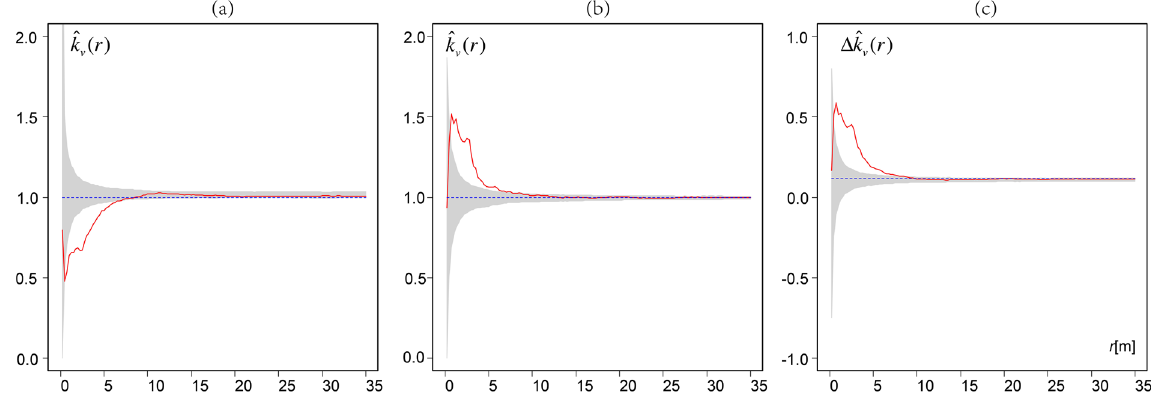
ˆ ) of simulated data for small trees ( a ), large trees ( b ), and their Figure 3. Mark mingling functions ( k r ( ) v ˆ ∆ ) in terms of non-normalised mark mingling functions ( c ). Solid curves: observed mark difference ( k r ( ) v mingling functions. Envelopes (grey areas): independent marking patterns constructed using the 2.5% and 97.5% quantiles of 1,000 Monte Carlo simulations. Dotted lines: expected mingling values under independent marking patterning. Note: It indicates an aggregation of similar tree species if mark mingling function ˆ k r ( ) v ˆ curves are above the curves fall below the simulation envelops. Different tree species are aggregated if k r ( ) v ∆ ˆ simulation envelops. Larger trees exhibit greater neighbourhood mingling than do smaller trees if the k r ( ) v curves lie above the simulation